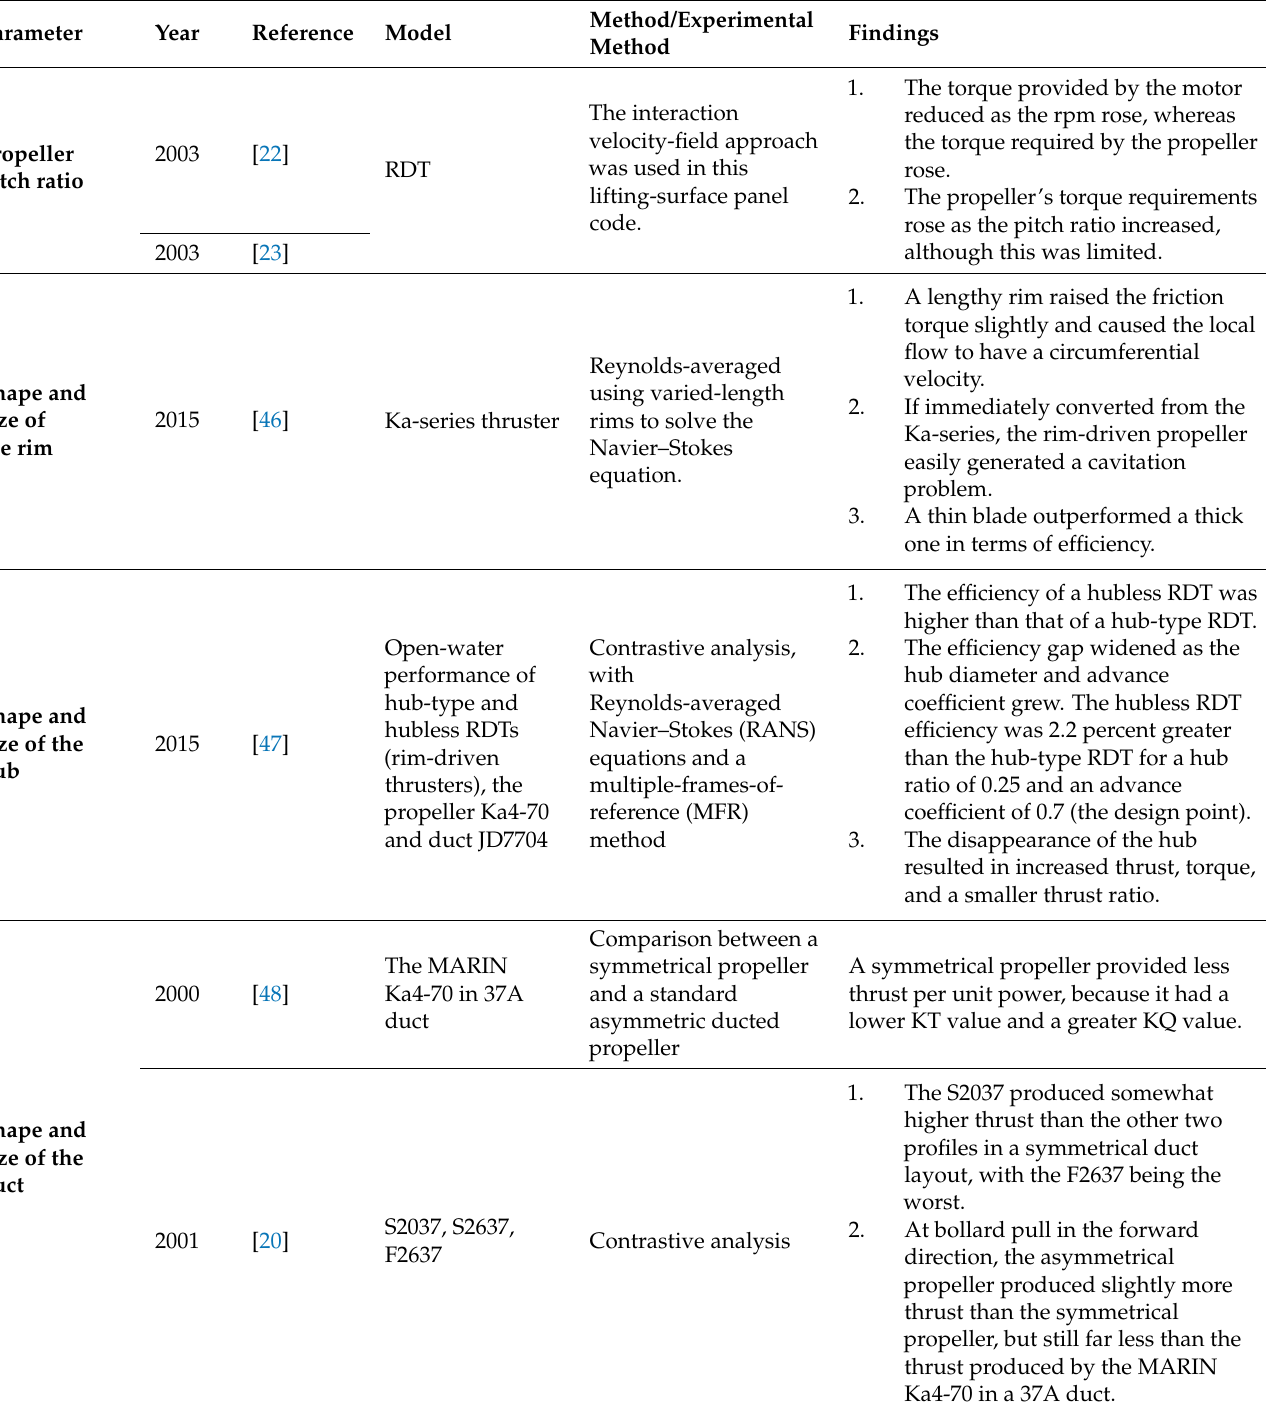
Table 3. Summary of numerical studies on the hydrodynamic performance of IMP